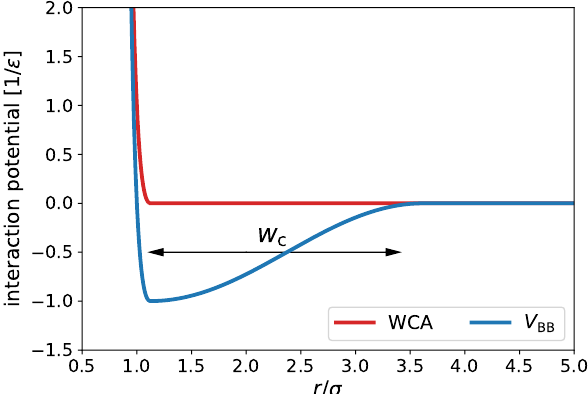
Figure 1. WCA potential (red) and hydrophobic–hydrophobic potential, V BB (blue), as a function of the interparticle separation. The arrow indicates the width w c of the attractive part of V BB